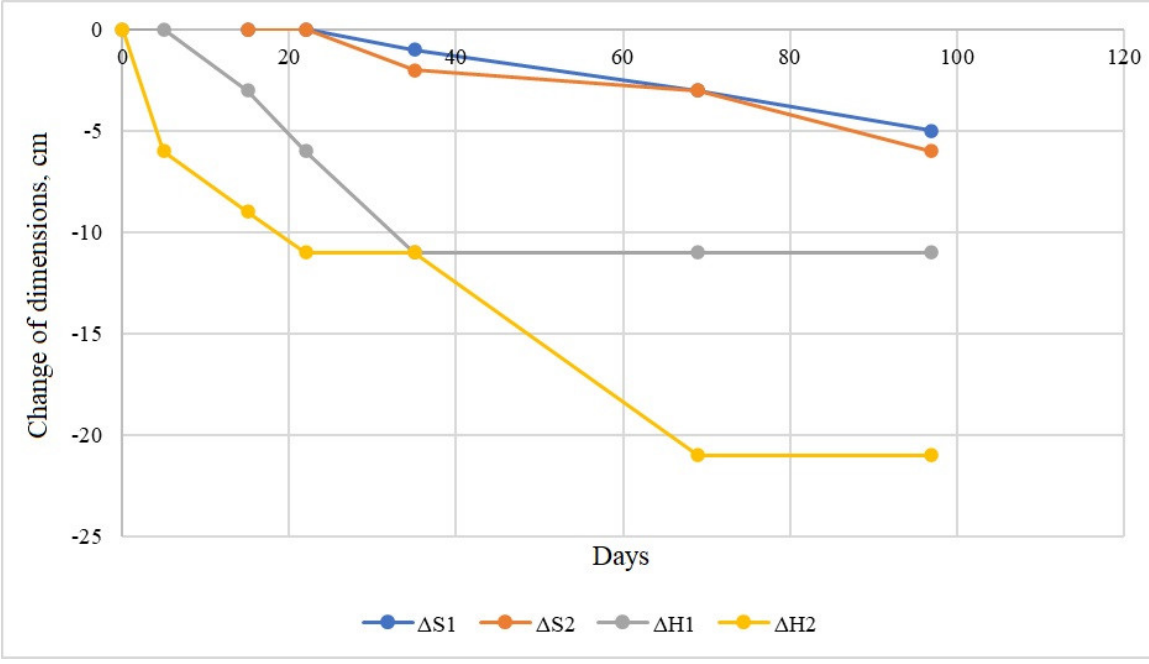
Figure A9. Change of the roadway dimensions—convergence control station no.5.